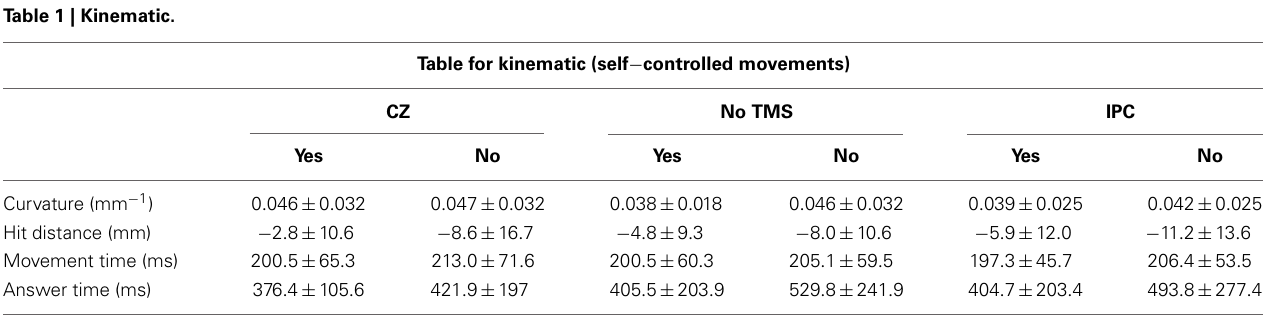
Table for kinematic (self − controlled